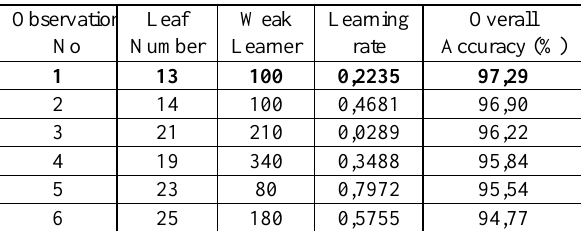
Table 2. Parameter values belonging to RUSBoost